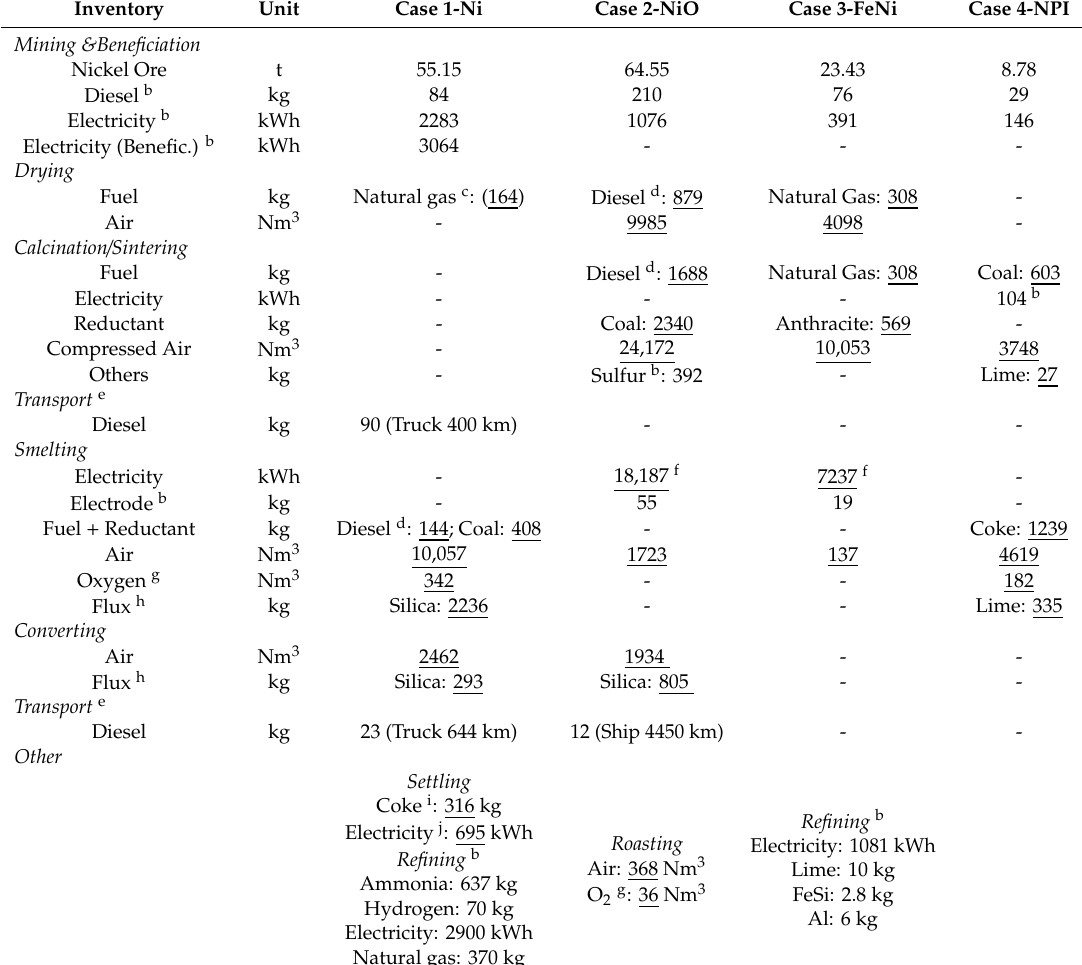
Table 8. Inventory of one tonne of nickel alloy production